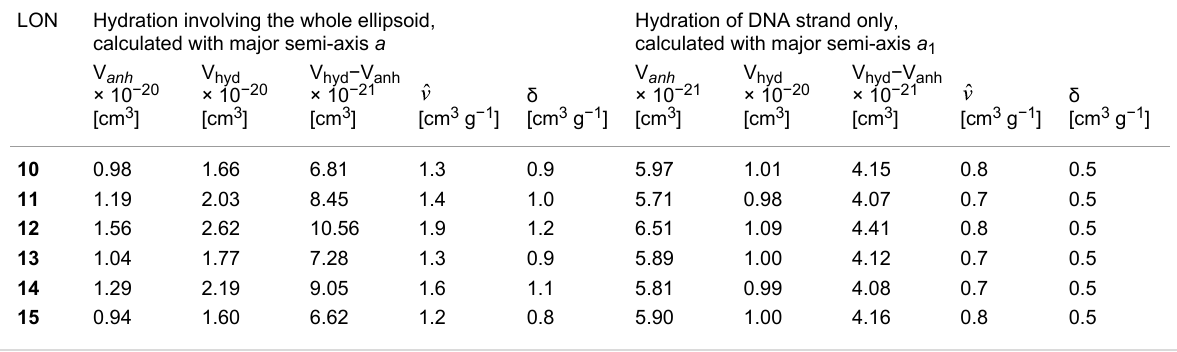
Table 5: V hyd , V anh and partial specific volume as well as the degree of hydration ( δ ) for LONs 10 – 15 . LON Hydration involving the whole ellipsoid, calculated with major semi-axis